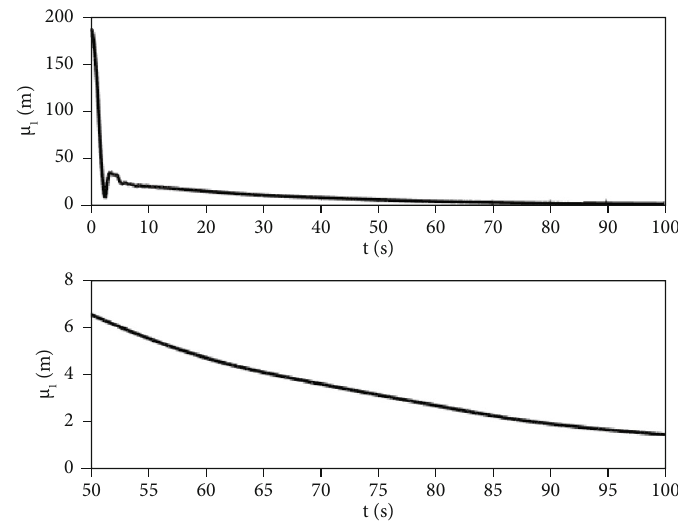
Figure 6: Missile formation tracking